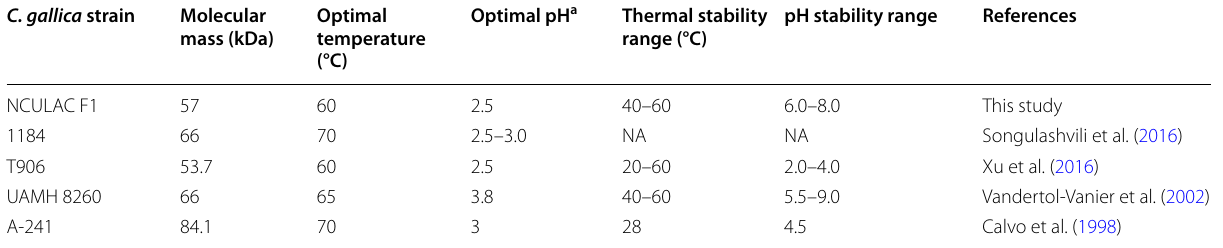
NA not available a The pH optima of laccase were determined with ABTS as substrate